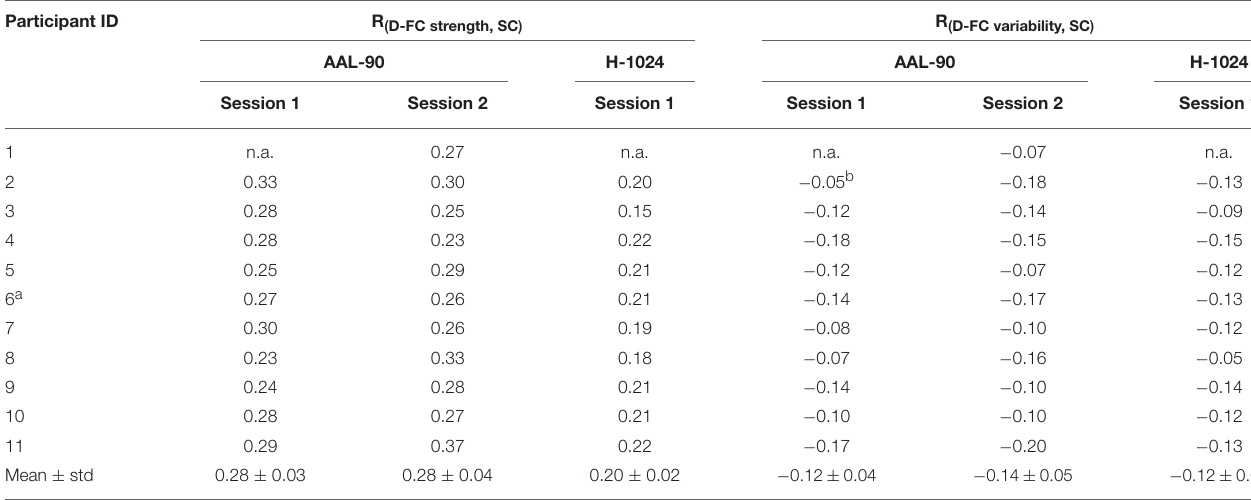
TABLE 2 | Relationship between dynamic functional connectivity and structural